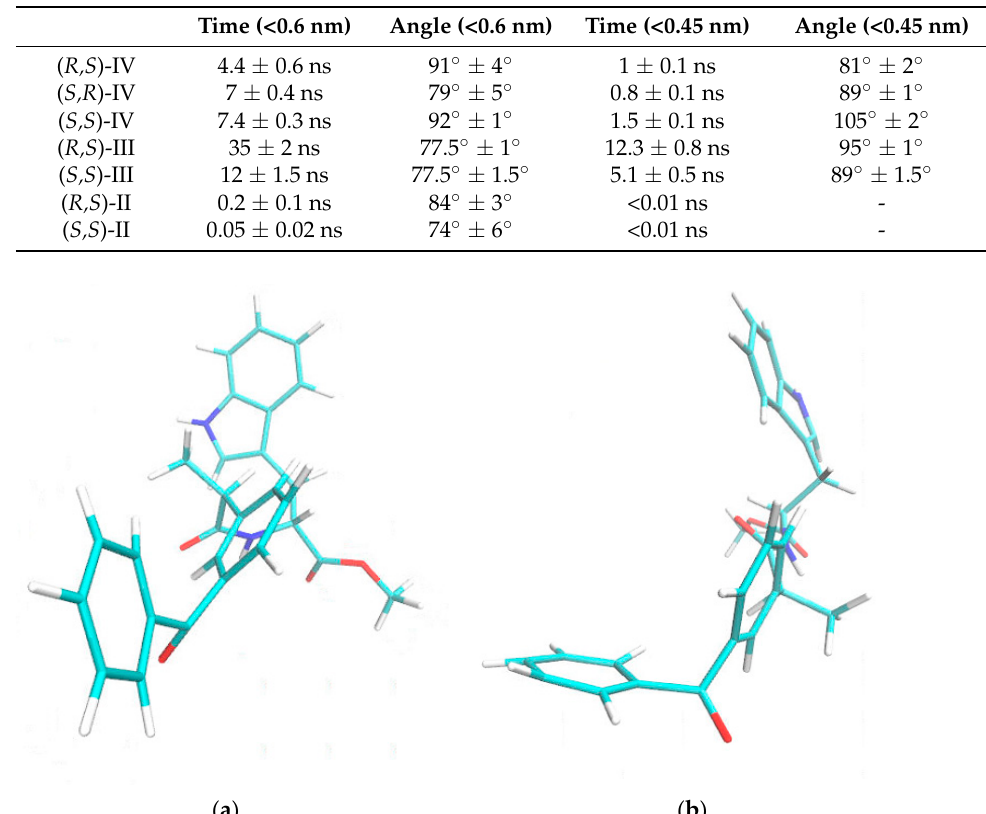
Figure 4. Snapshots of MD trajectories for ( a ) ( S,R )-IV and ( b ) ( R,S )-IV illustrating different mutual orientation of ketoprofen aromatic rings.